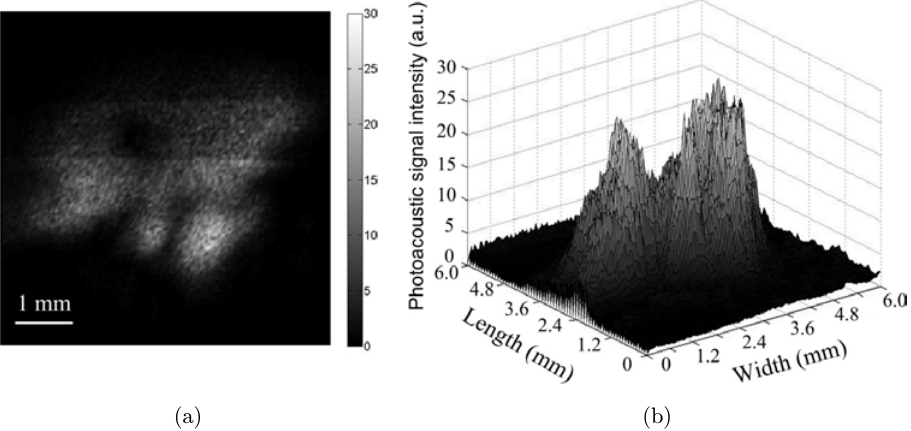
Fig. 5. Photoacoustic imaging (a) and corresponding signals (b) of ICG (cid:1) PL (cid:1) PEG nanoparticles. Photoacoustic imaging (c) and corresponding signals (d) of ICG. The ICG (cid:1) PL (cid:1) PEG nanoparticles and ICG were injected directly into the °ank region of female Balb/c